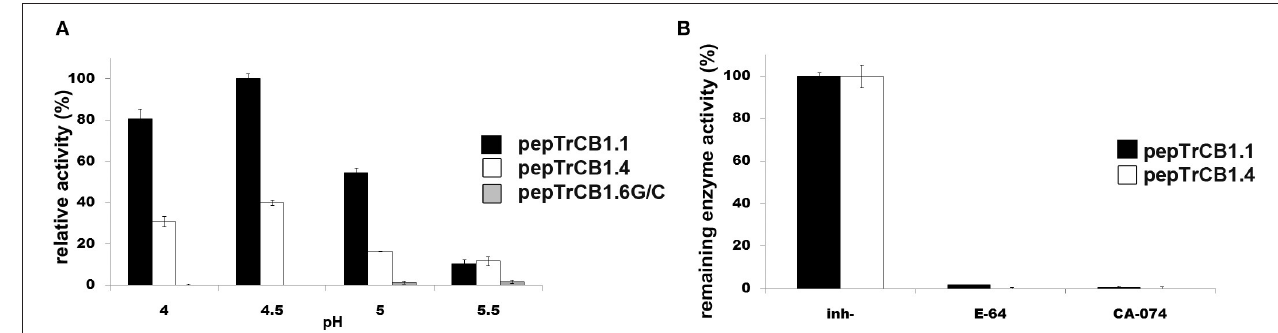
FIGURE 7 | Peptidyl-dipeptidase activity of the pepTrCB1 forms and the effect of inhibitors. (A) pepTrCB1 forms were incubated with Bz-Gly-His-Leu substrate in 50/100mM CPB (pH 4–5.5) containing 2mM DTT. The appearance of arising free amino groups was monitored by reaction with fluorescamine (0.05 mg/ml). (B) The